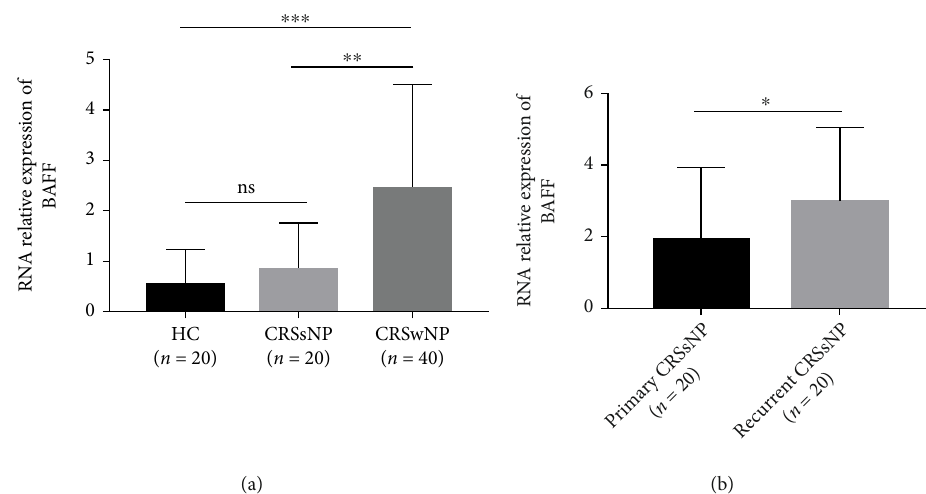
Figure 2: Comparison of tissue BAFF mRNA levels among three groups. (a) Tissue BAFF relative expressions were enhanced in the CRSwNP group than the CRSsNP and HC groups. (b) Tissue BAFF relative expressions were higher in the recurrent CRSwNP group than the primary CRSwNP group. BAFF: B cell-activating factor; CRSwNP: chronic rhinosinusitis with nasal polyps; CRSsNP: chronic rhinosinusitis without nasal polyps; HC: healthy control; NS: no signi fi cance. ∗ P < 0 : 05 and ∗∗ P < 0 : 01 .